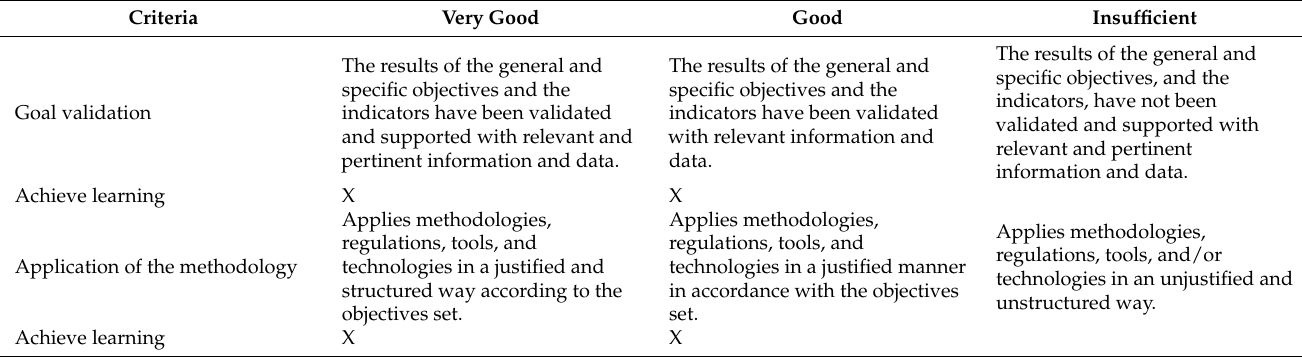
Table 1. Assessment rubric with levels of learning